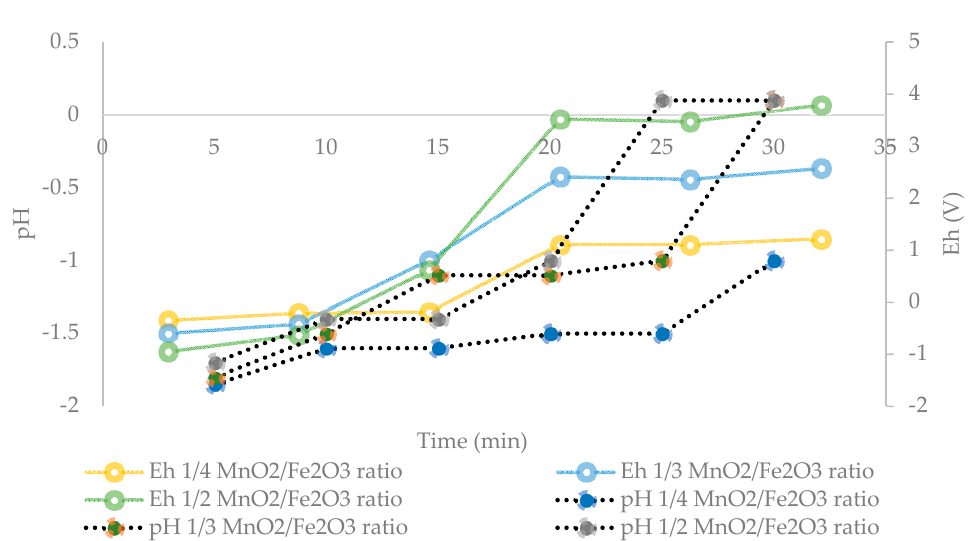
Figure 6. Effect of the potential and pH in solution at different MnO 2 /Fe 2 O 3 ratios (25 °C, 600 rpm, − 75 + 53 μ m, acid concentration of 0.1 mol/L).